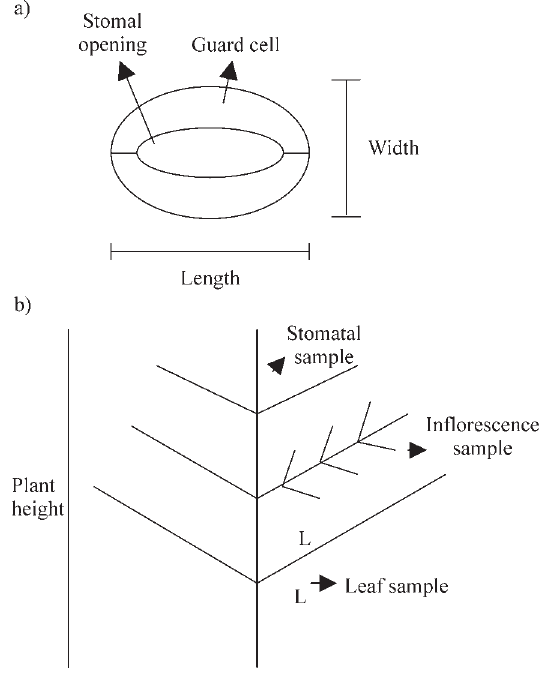
Figure 1 - a) Diagram of a stoma indicating the positions used to measure the length and width. b) Diagram of Stevia rebaudiana (Bertoni) Bertoni, indicating the location of the points of stomatal, leaf and inflorescence sampling and the procedure used to determine plant height (L =